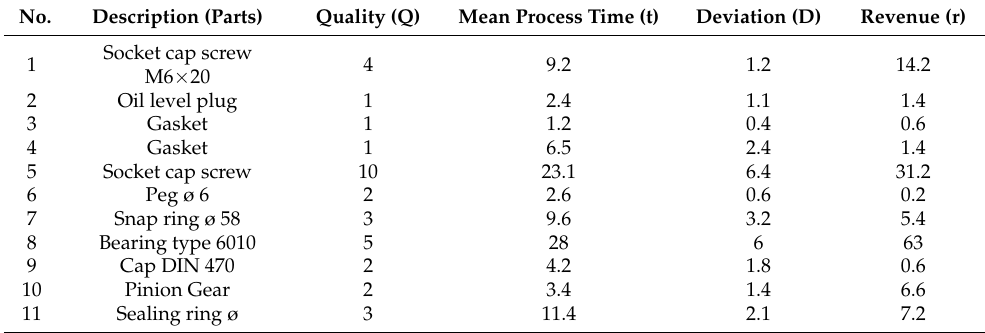
Table A2. Bill of materials of Splitter Gearboxes Series